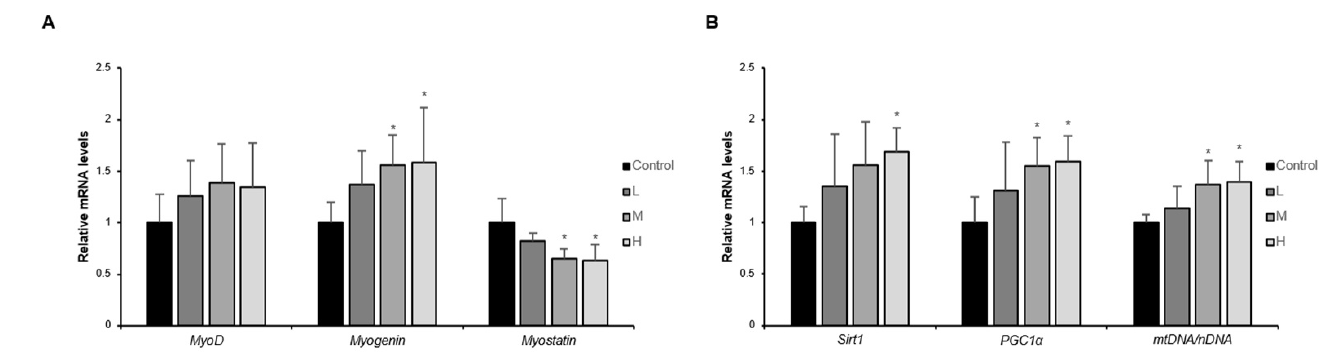
Figure 4. Effect of the GBE + WPH mixture on muscle regeneration and mitochondrial biogenesis. Ten-month-old male C57BL/6 mice were administered three different doses of the GBE + WPH mixture for 8 weeks; 700 mg/kg, 900 mg/kg, and 1100 mg/kg. ( A ) Relative mRNA expression of factors related to muscle regeneration (Myostatin, Myogenin, and MyoD). ( B ) Relative mRNA expression of factors related to mitochondrial biogenesis (Sirt1, PGC1a, and mtDNA/nDNA). The gene expression levels were normalized to β -actin level. The data are shown as mean ± SD. * p < 0.05 versus control.